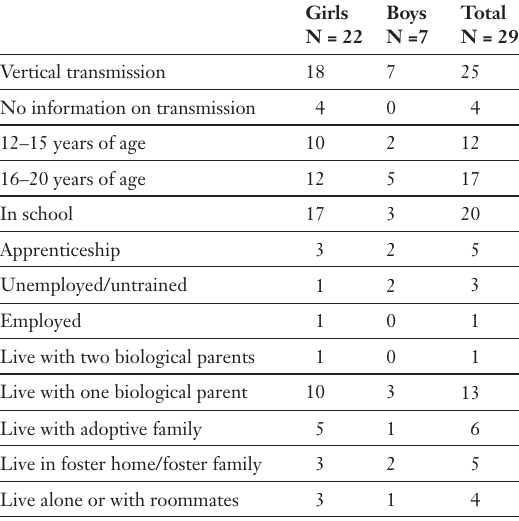
Selected background characteristics of the